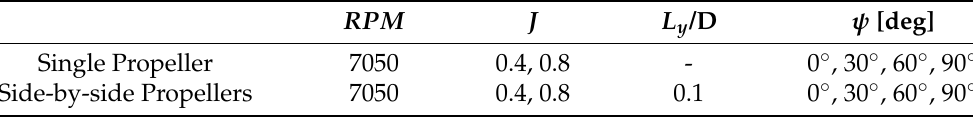
Table 1. Stereo PIV measurement test matrix of the wind tunnel campaign.